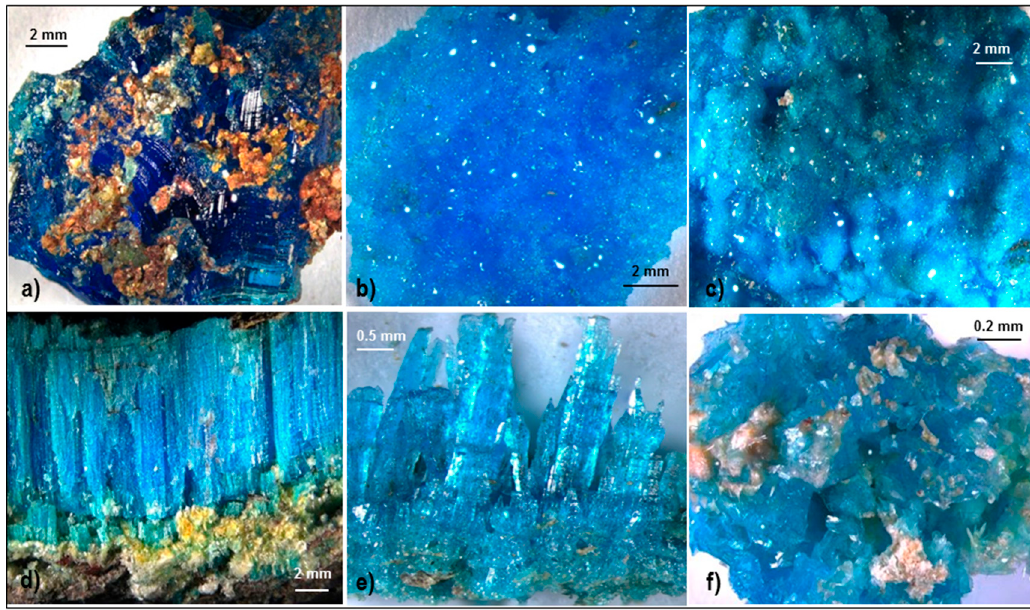
Figure 8. Several aspects of chalcanthite: Vitreous deep blue masses ( a ), light blue crystals ( d – f ), fibrous columnar crystalline ( d ) and crusts ( b , c ) (stereomicroscope images).